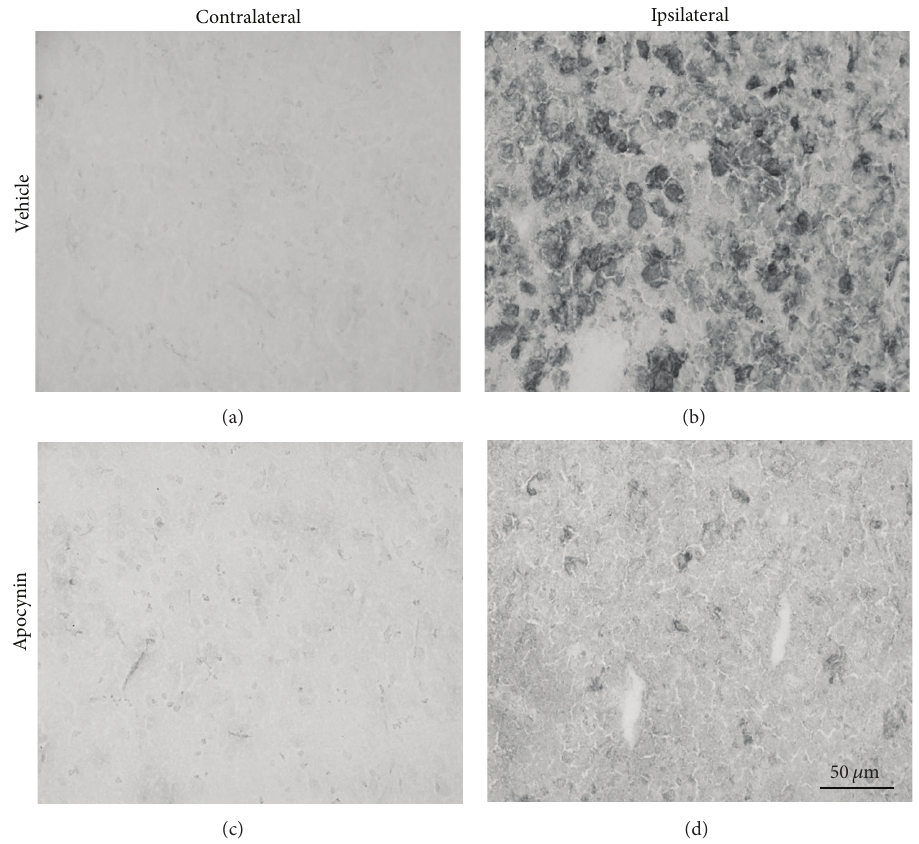
F 6: Immunohistochemical localization of cortical NADPH oxidase subunit Nox2 in the stroke-affected cortex (b), (d) and the contralateral mirror image ((a), (c)), in vehicle control ((a), (b)) and apocynin- ((c), (d)) treated rats. Micrographs taken from the core infarct region 3 days aer stroke show a reduction in Nox2 positive cells following apocynin treatment (d) compared with vehicle control